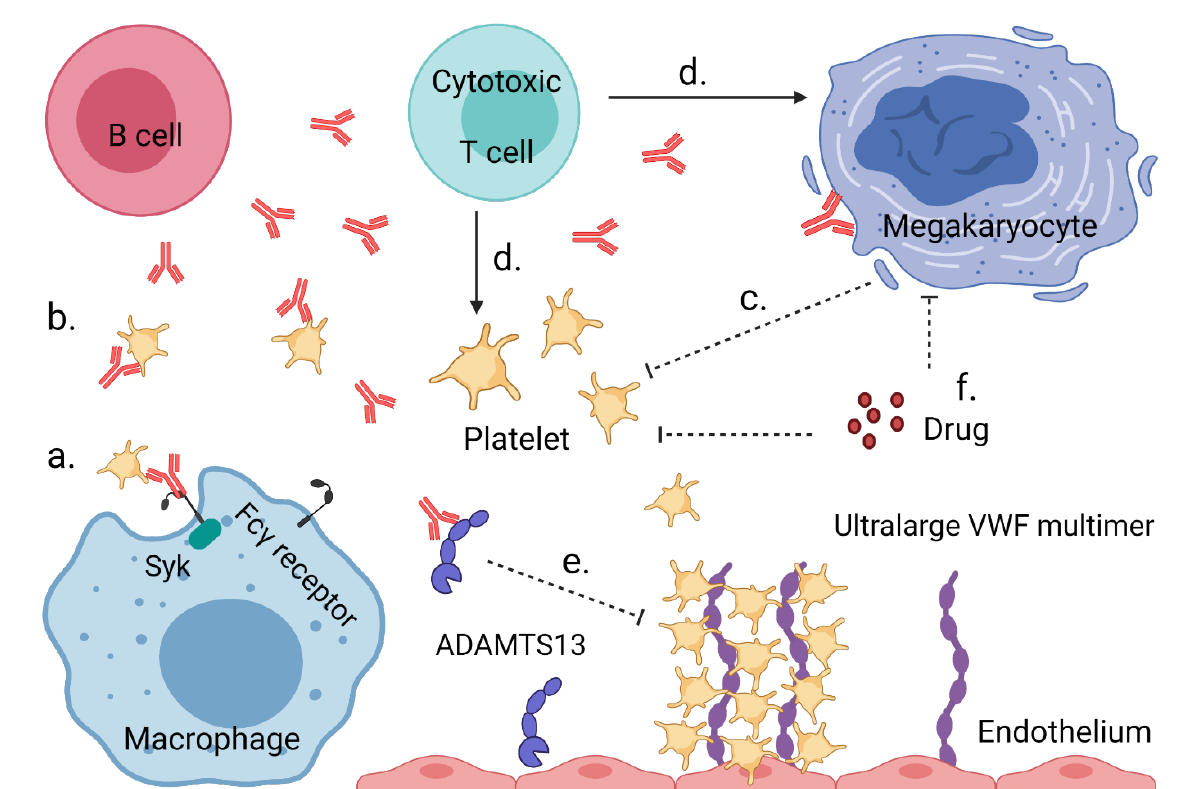
Figure 2. Mechanisms leading to low platelet count or thrombocytopenia in IIT. a| Auto-antibodies target platelets for destruction by macrophages in the spleen or liver through Fc γ receptor signaling via spleen tyrosine kinase (Syk). b| Platelets decorated with auto-antibodies can also be destroyed via other mechanisms, such as complement activation or desialylation. c| Auto-antibodies binding to megakaryocytes can lead to an impaired platelet production. d| Cytotoxic T cells can directly destroy or inhibit platelets and megakaryocytes. e| Binding of ultra-large VWF multimers to platelets induces microthrombus formation in the absence of functional ADAMTS13 (either inhibited by auto-antibodies or not expressed due to a congenital defect). f| Chemotherapeutic antiproliferative drugs can suppress megakaryocyte development and platelet production. Created with Biorender.com.